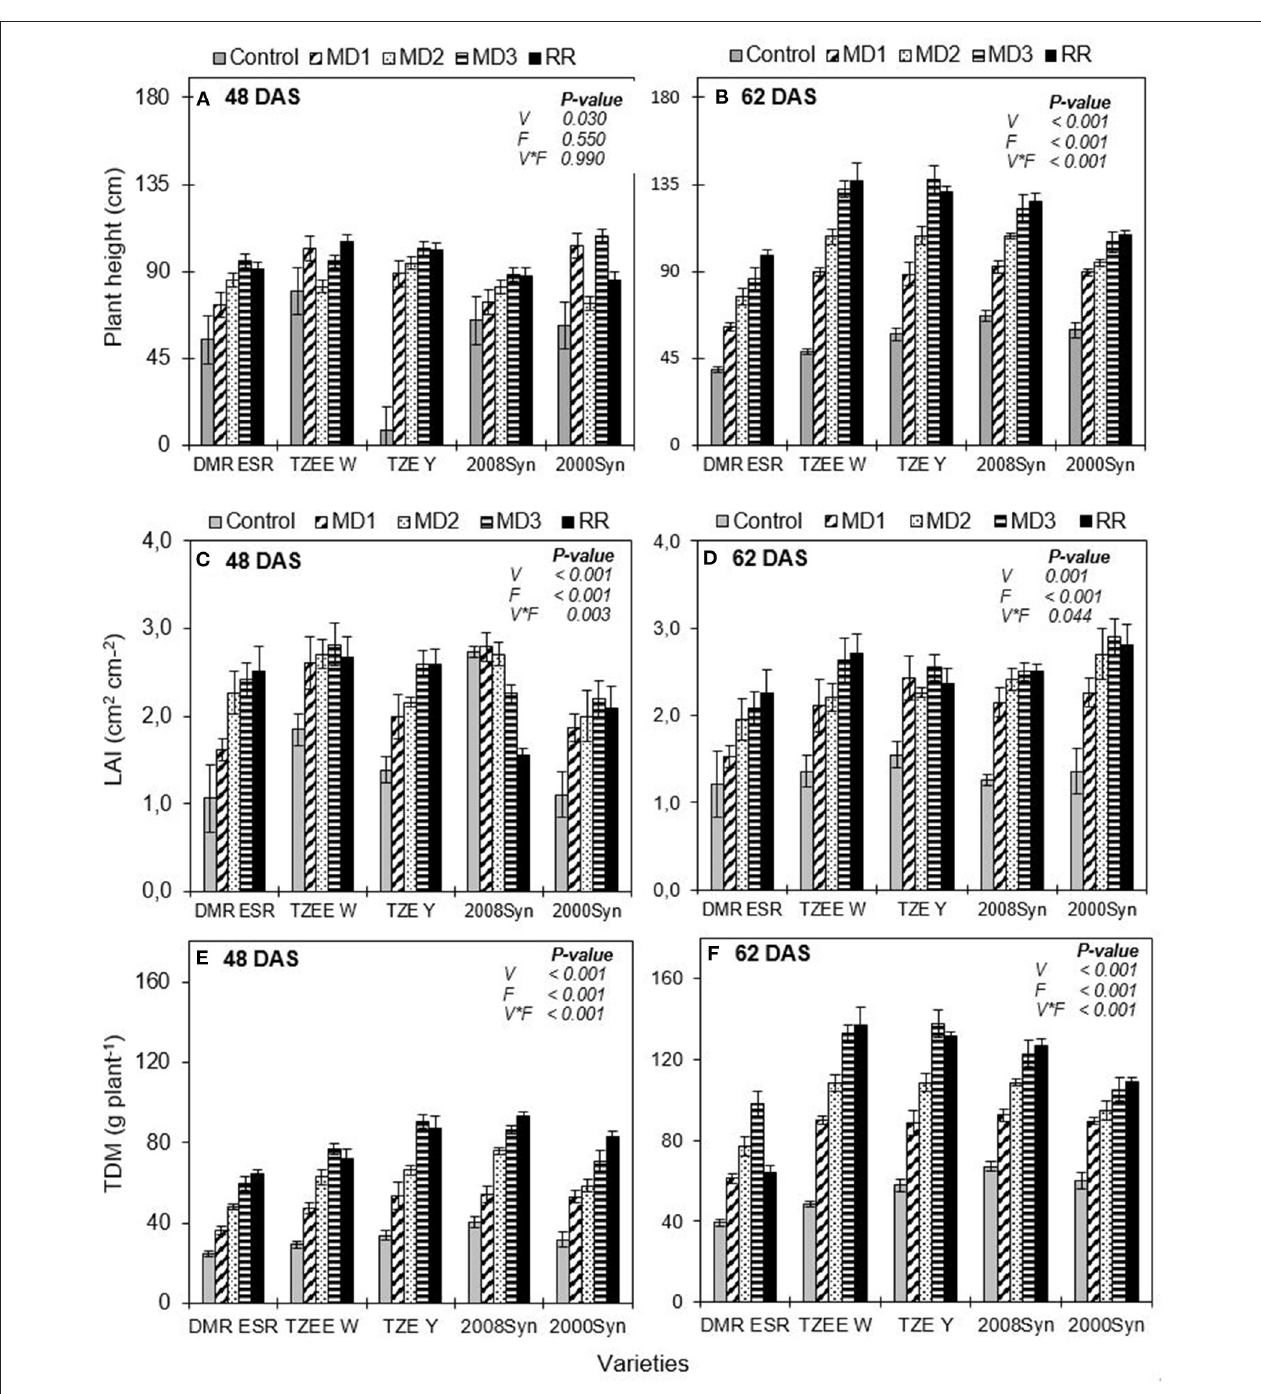
FIGURE 3 | Plant height (A,B) , leaf area index [LAI, (C,D) ], and total dry matter [TDM, (E,F) ] at 48 (A,C,E) and 62 DAS (B,D,F) as affected by the interactions between varieties and mineral fertilizer. Control refers to the absolute unfertilized treatment; MD1 (N25P4), MD2 (N25P8), MD3 (N35P8), and RR (N76P13) refer to fertilizer microdosing options 1, 2, and 3 and the recommended fertilizer rate, respectively. ns, non-significant; Error bars represent standard deviations. V, Variety; F, Fertilizer. and between fertilizer treatments ( p < 0.001). The Ph values were 42.6, 44.8, 43.1, and 26.6% higher for TZEE-W, TZE-Y, 2008Syn-EE, and 2000Syn-EE varieties, respectively, compared